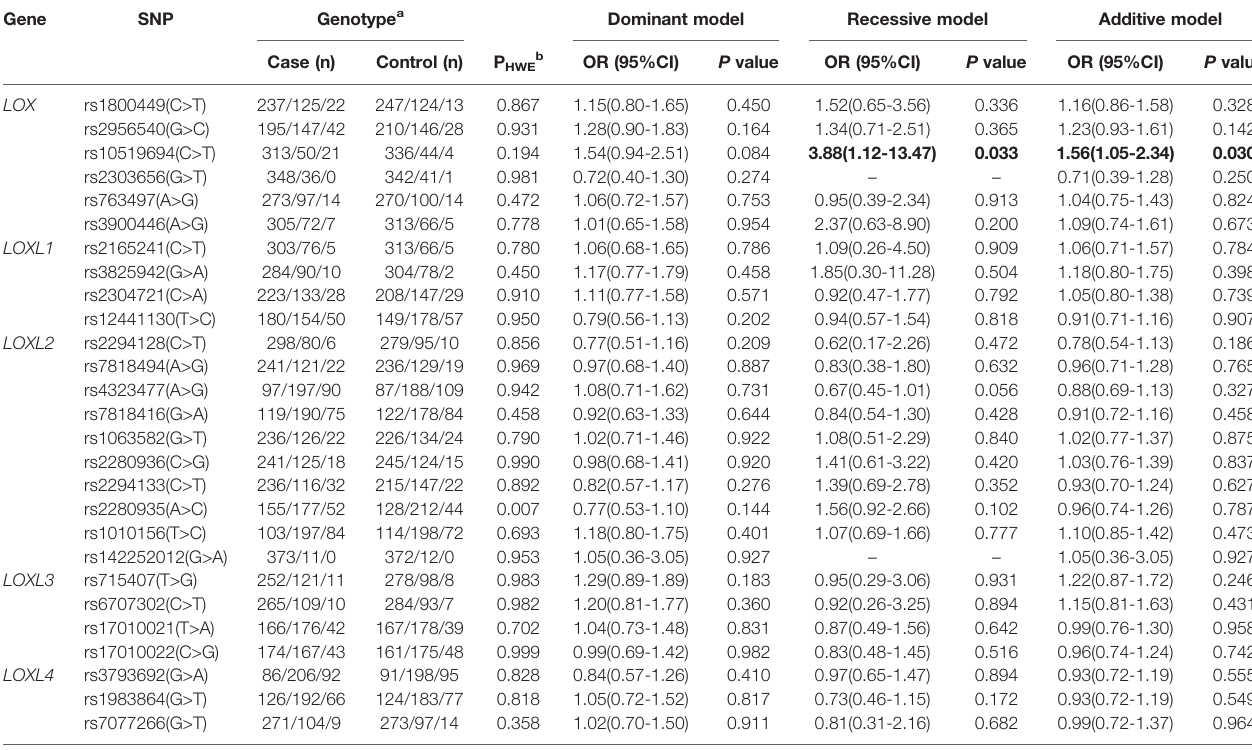
TABLE 3 | Multivariate logistic regression analysis of association of polymorphisms in LOX family genes and risk of IA in Chinese population. Gene SNP Genotype a Dominant